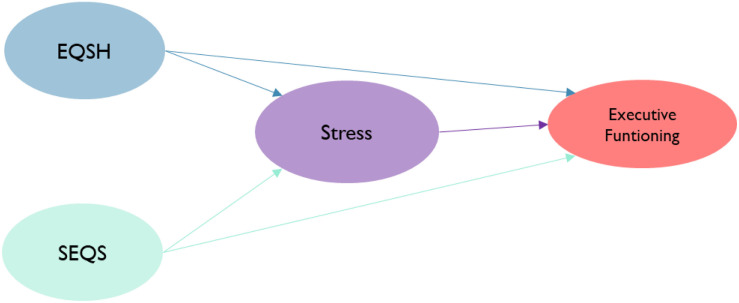
Formative model.